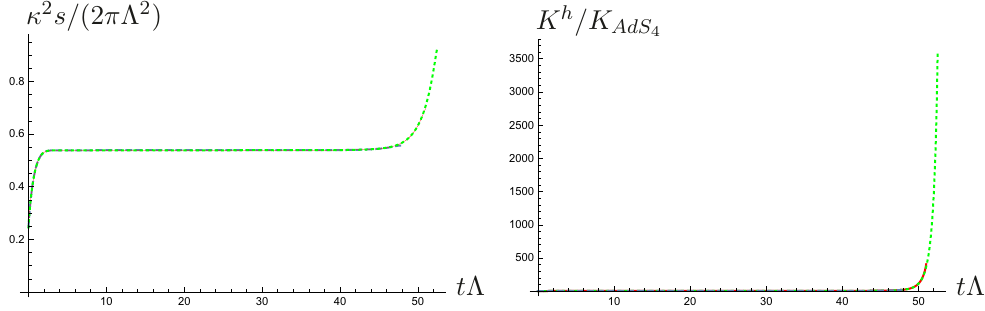
Figure 16 . Evolution of the entropy density s and the Kretschmann scalar K h evaluated at the apparent horizon in dynamics of sBBL model with g = < crit . Different color coding represents different spatial resolutions of the numerical E E